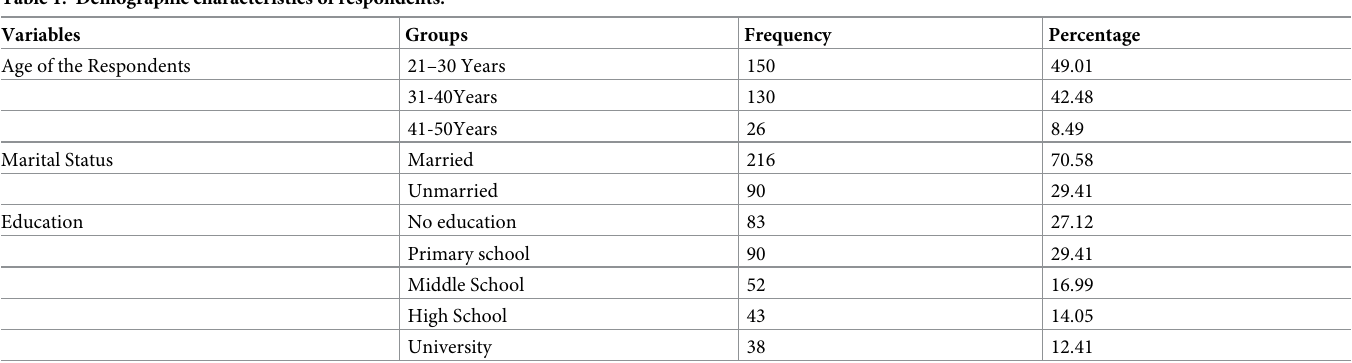
Table 1. Demographic characteristics of